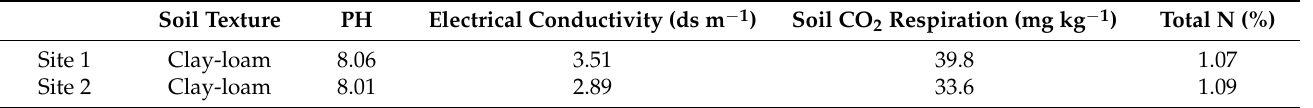
Figure 1. Study sites at The Medjool Village, Jordan Valley, Jordan. Asterisk (*) represents the tree location (site 1 and 2) from which the fruit were sampled for anatomical observations. Table 1. Soil analysis of experimental sites at the Medjool Village, Jordan Valley,